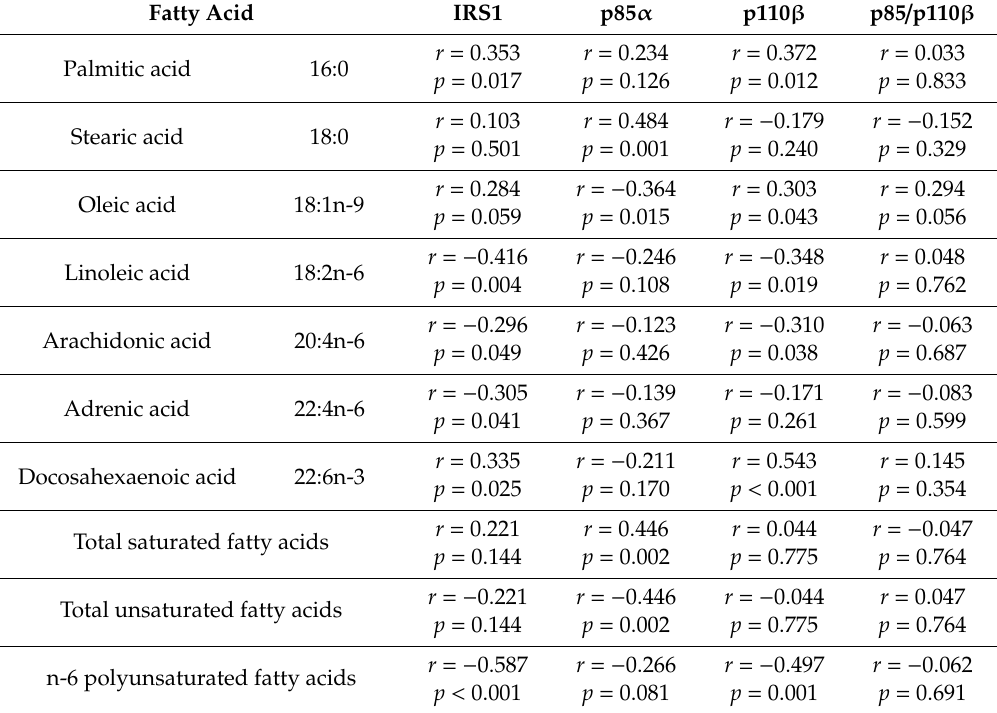
Table 3. Significant correlations ( p ) between the fatty acid composition of phospholipids and